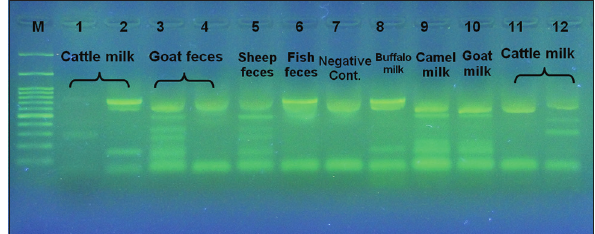
Figure-1: Agarose gel electrophoreses of polymerase chain reaction (PCR) products from multiplex PCR assays. Multiplex PCR assays were performed with a mixture of seven species-specific or group-specific primers for L. acidophilus , L. bulgaricus (same as L. delbrueckii subsp. bulgaricus ), L. casei -group L. gasseri , L. plantarum , L. reuteri, and L. rhamnosus and two bacterial conserved primers. Lanes 1-12 designate the PCR product from each genomic DNA extracted from single or mixed cell suspension isolated from representative host used as PCR template. Lane 1: L. casei